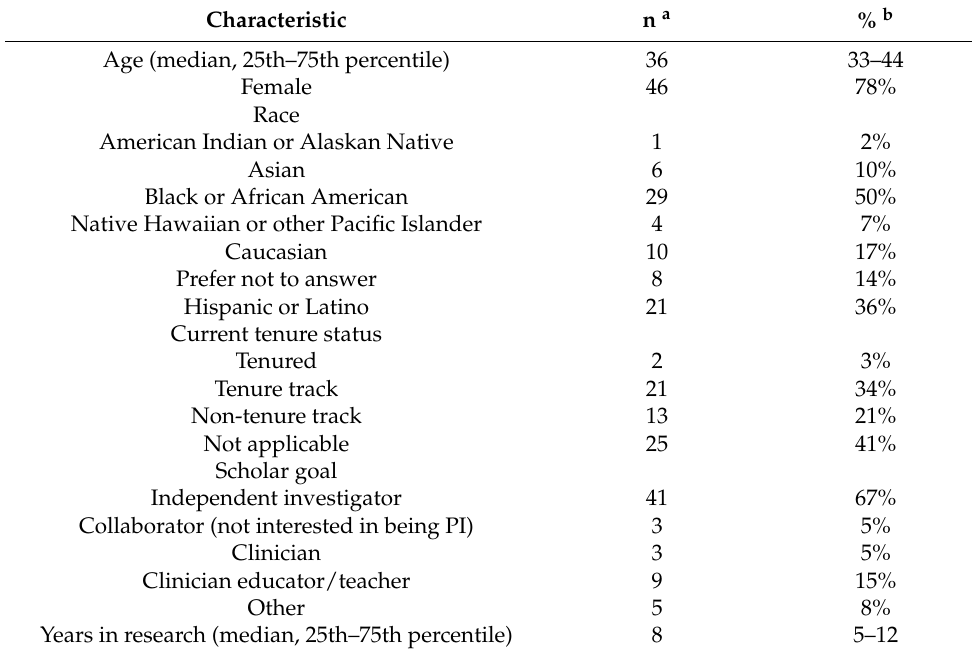
Table 1. Population characteristics of the scholars from the baseline survey (n =